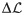
Distributions of positional errors in conflicting and coherent phases.A. Distributions of positional errors in the decoded cognitive map during coherent/stable (red) and conflicting/unstable (blue) phases. The model predicts (left panel) that the mean error is significantly increased during conflicting periods, mirroring the dispersion of the neural representation induced by the conflicting input streams. The same phenomenology is observed in recordings (right panel). B. The over-dispersion of the neural code in the ‘correct’ cognitive state (reported in panel A) is caused by an increased precision of the positional representation in the ‘opposite’ map, i.e. the one where the bump is not localized. This effect is significant in the model, left panel, and in the recorded data, right panel. C, D. Same analysis after exclusion of flickering theta bins. E. The absolute value of the log-ratio ΔL, Eq (1), is significantly reduced during the conflicting phase, both in the model (left) and in the data (right panel;). |ΔL| is a proxy for the completeness and stability of the bump (Methods). F Distributions of ΔL in the test session during the conflicting (left, blue) and the coherent (right, red) phases, compared to the distribution in the two reference sessions (black contour, same as in Fig 2A).